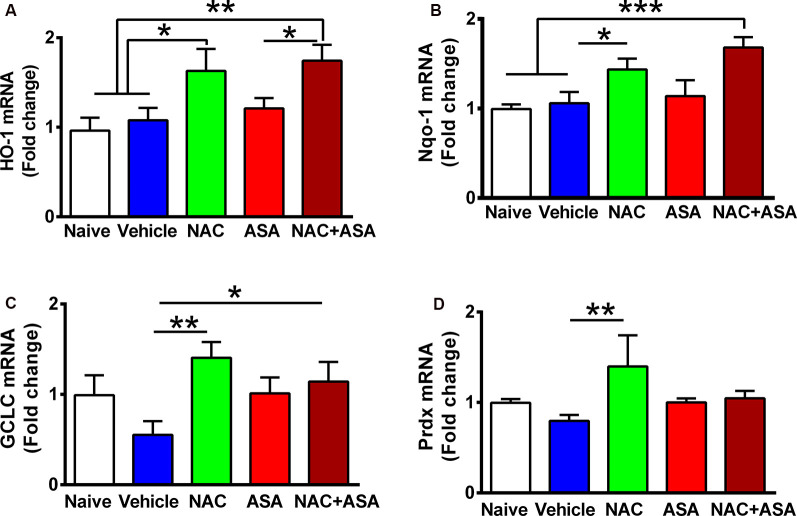
Oral administration of N-acetylcysteine (NAC; 40 mg/kg per day), but not acetylsalicylic acid (ASA; 15 mg/kg per day), increased the expression of Nrf2-ARE regulated genes in the hippocampus of chronically alcohol-consuming rats. Reduction of chronic ethanol intake induced by the oral administration of NAC (40 mg/kg per day) shown in Figure 1 was associated with a significant increase in the hippocampal level of Nrf2-ARE regulated genes compared to chronic ethanol drinking rats receiving vehicle or compared to naive rats that had ingested only water. A one-way analysis of variance (ANOVA) performed on ethanol intake data revealed significant effect of treatment on (A) heme oxygenase 1 (HO-1) mRNA levels (ANOVA F(4, 24) = 6.417, **P < 0.01); Tukey post hoc test revealed that rats treated with NAC or NAC + ASA showed in the hippocampus a greater mRNA expression of HO-1 vs. vehicle group (*P < 0.05 vehicle-treated vs. NAC- and **P < 0.01 vs. NAC + ASA-treated groups). (B) Quinone oxidoreductase 1 (Nqo1) levels. ANOVA Ftreatment(4, 26) = 5.332, **P < 0.01. Post hoc test revealed that rats treated with NAC or NAC + ASA showed greater mRNA expression of Nqo1 vs. vehicle group (*P < 0.05 vehicle-treated vs. NAC-treated group, ***P < 0.001 vehicle-treated and naive vs. NAC + ASA-treated group). (C) γ-Glutamyl-cysteine synthetase (GCLC) mRNA levels. ANOVA Ftreatment(4, 26) = 2.852, **P < 0.01. Post hoc test revealed rats treated with NAC or NAC + ASA showed greater mRNA expression of GCLC vs. vehicle group (**P < 0.01 vehicle-treated vs. NAC-treated group, *P < 0.05 vehicle-treated vs. NAC + ASA–treated group) and (D) peroxiredoxin (Prdx) mRNA levels. ANOVA Ftreatment(4, 26) = 2.912. Post hoc test revealed rats treated with NAC showed greater mRNA expression of Prdx vs. vehicle group (**P < 0.01 vehicle-treated vs. NAC-treated group). Data of each target gene were normalized by the expression of the housekeeping gene glyceraldehyde-3-phosphate dehydrogenase (GAPDH) in the same sample. Data are presented as mean ± SEM, n = 6 rats per experimental group.